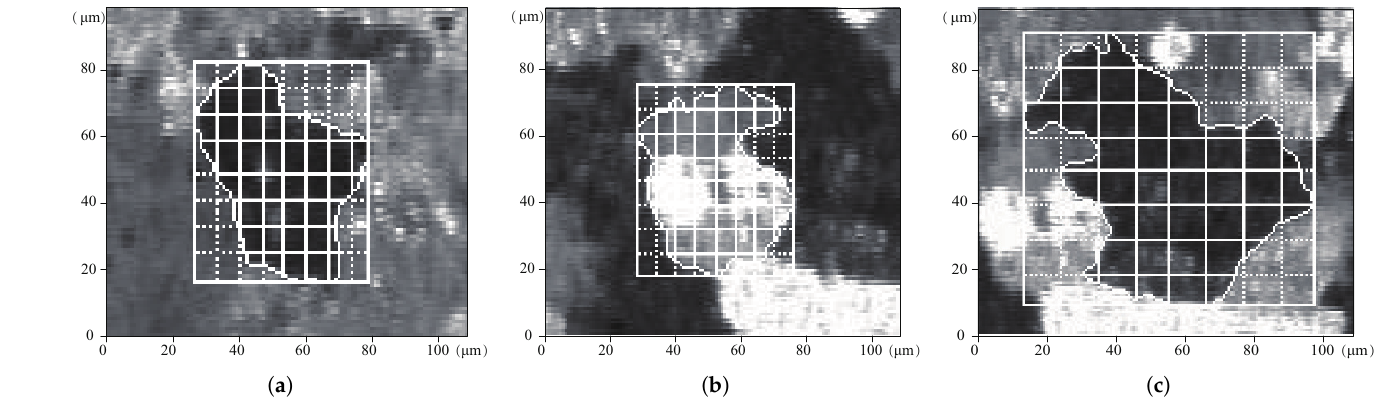
Figure 5. The multi-chord fitting of three grain boundaries: ( a ) grain 1; ( b ) grain 2; ( c ) grain 3. We fit and calculate each chord (solid line part) in each grain in Figure 5. The calcula- tion data and shape parameters are listed in Table 1 according to the number of chords in each grain.